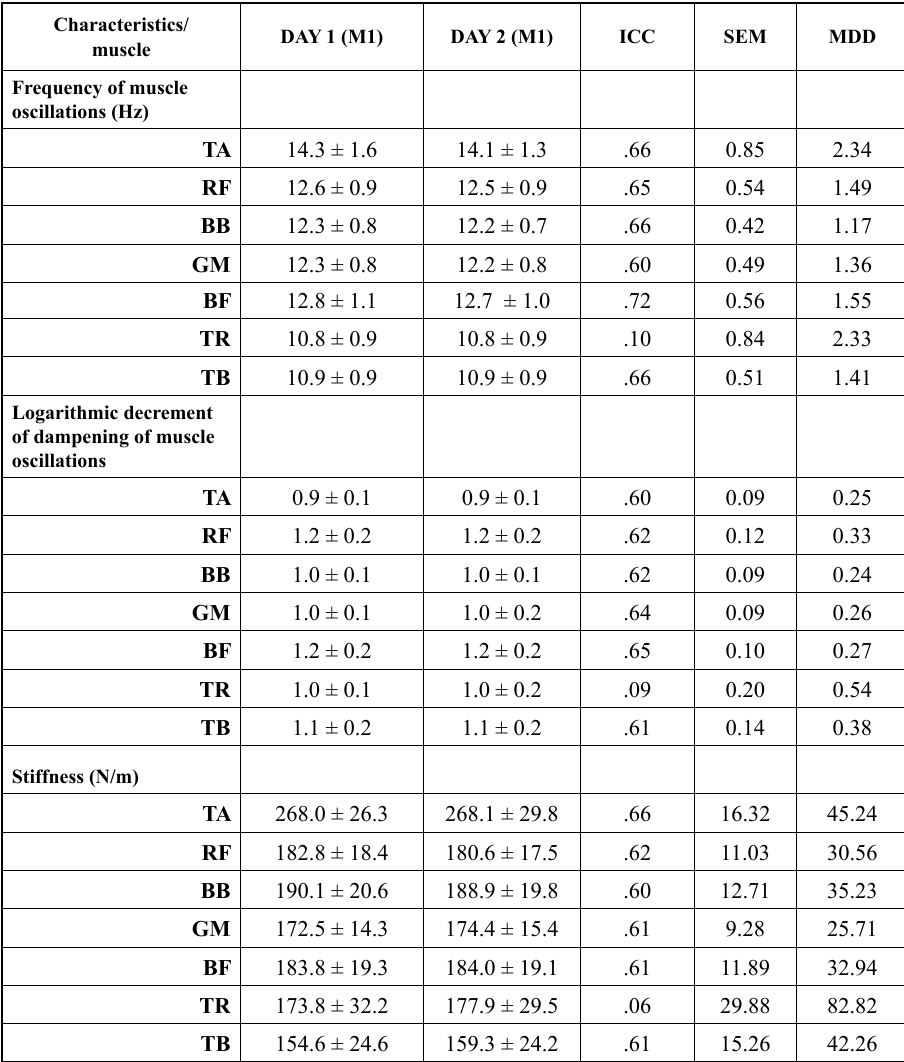
frequency, elasticity, stiff- ness (mean ± SD) and intrarater intra-class cor- relation (ICC), standard error of measurement (SEM), and minimal de- tected change in values of between days data (MDD) in healthy children aged 5–7 years ( n =